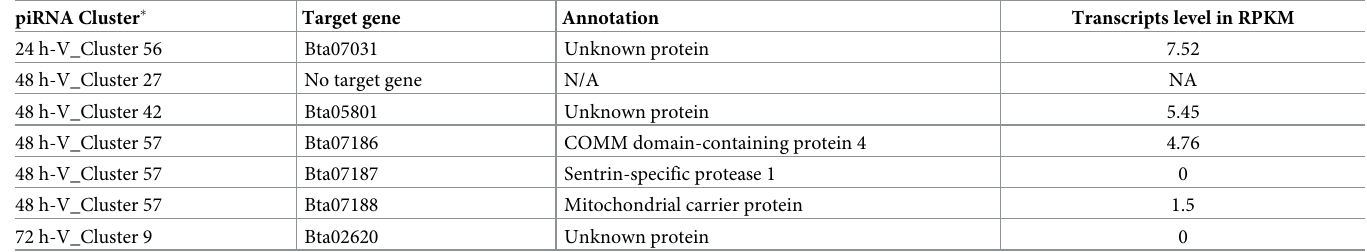
Table 5. Predicted target genes of induced piRNA clusters.